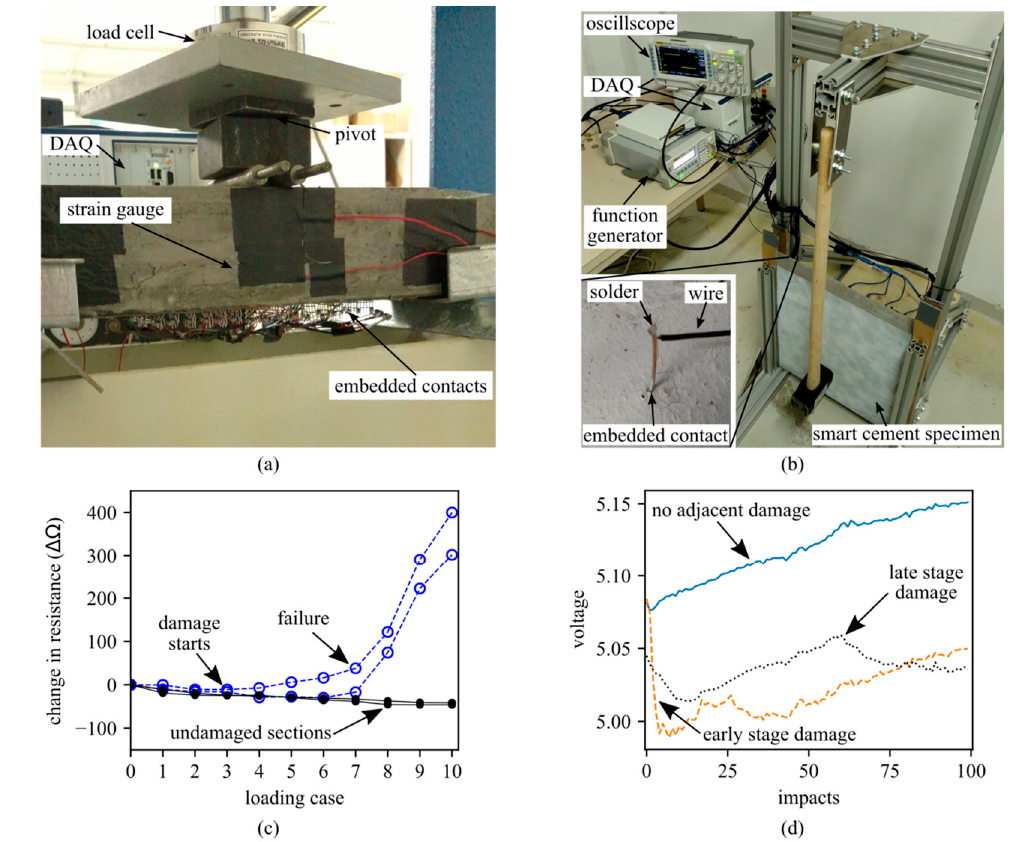
Figure 5. Example laboratory structural elements made of smart concrete for direct damage sensing: ( a ) Photo evidence of a smart concrete beam; ( b ) Photo evidence of a smart concrete plate; ( c ) Smart concrete beam electrical output exhibiting damage; ( d ) Smart concrete plate electrical output exhibiting